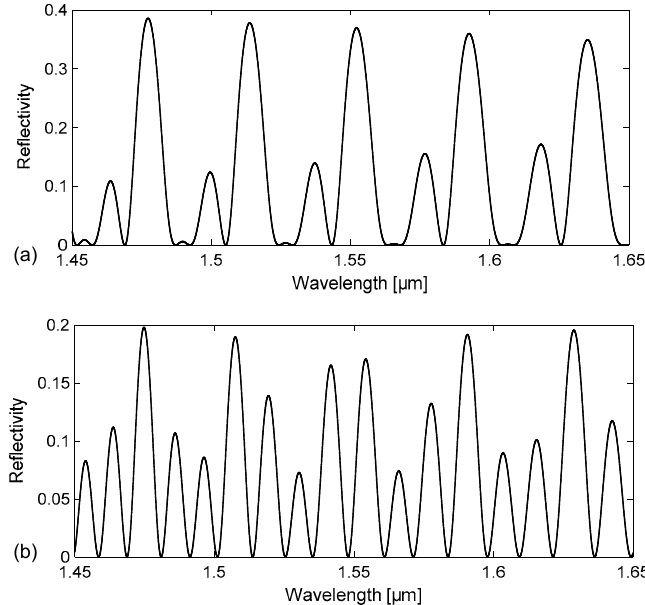
Figure 2. Calculated reflectivity spectra R( λ ) = P r ( λ )/P in ( λ ) for a rectangular–miniature hollow glass tubing with d = 30 µm, t f = t b = 21 µm (nominal dimensions): ( a ) empty channel; ( b ) channel filled with water.